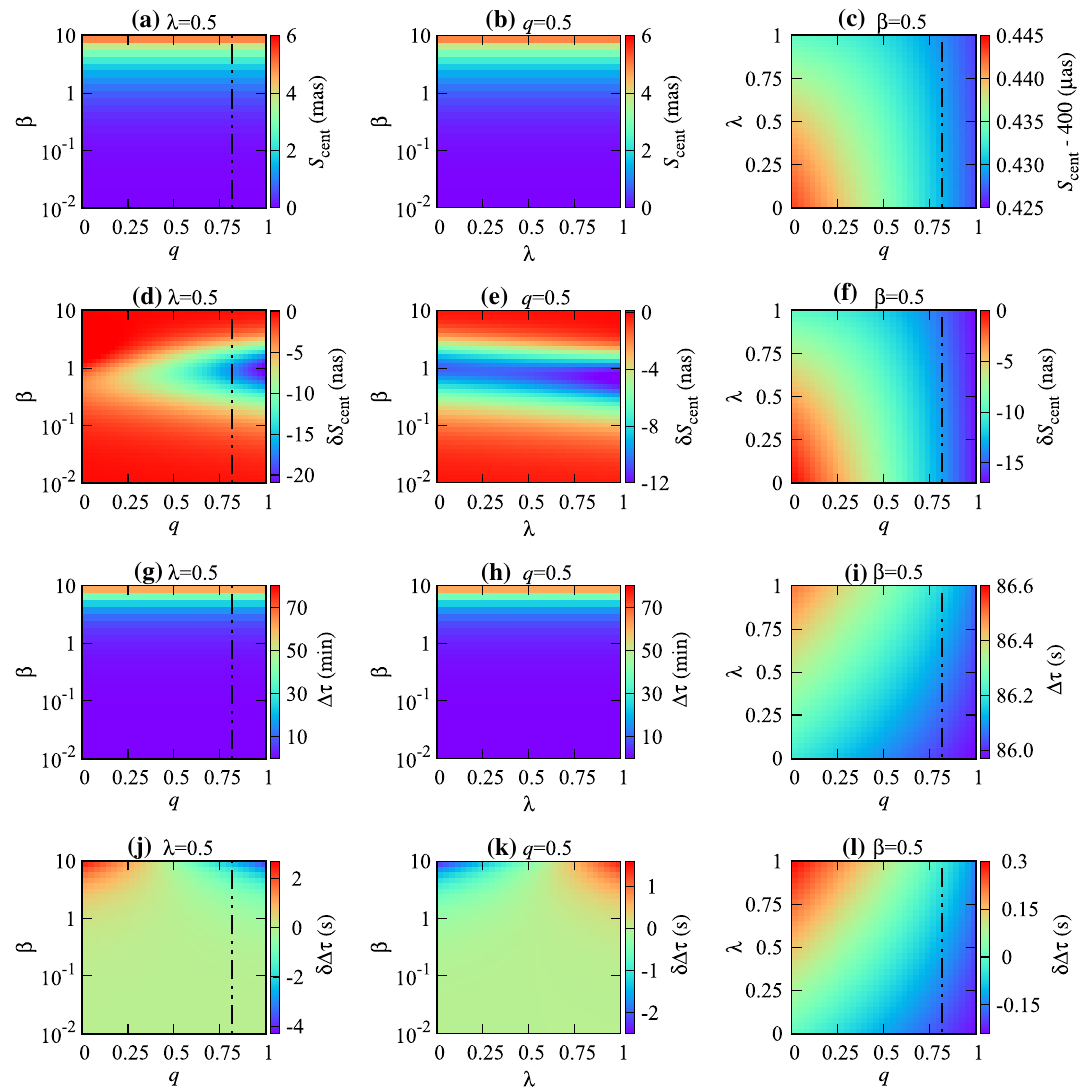
Fig. 4 From top to bottom, color-indexed S cent , δ S cent , Δτ and δΔτ in the weak deflection gravitational lensing for Sgr A* are shown on the domains of D λ , D q and D β (from left to right). The dash-dotted lines mark the upper bound on q based on the shadow of M87* observed by EHT (10)